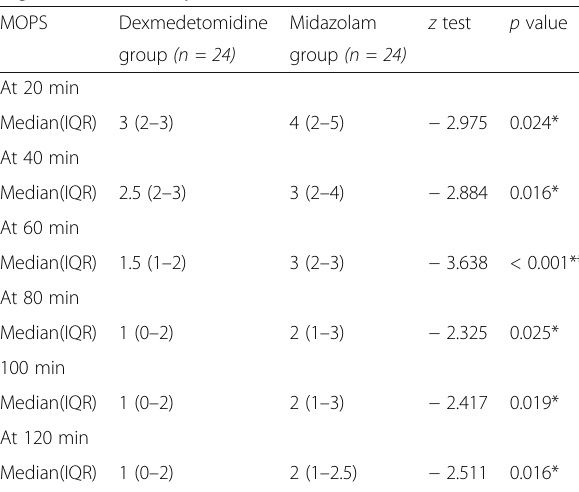
Table 11 Comparison between group D and group M as regards Modified Objective Pain Scale ( MOPS)